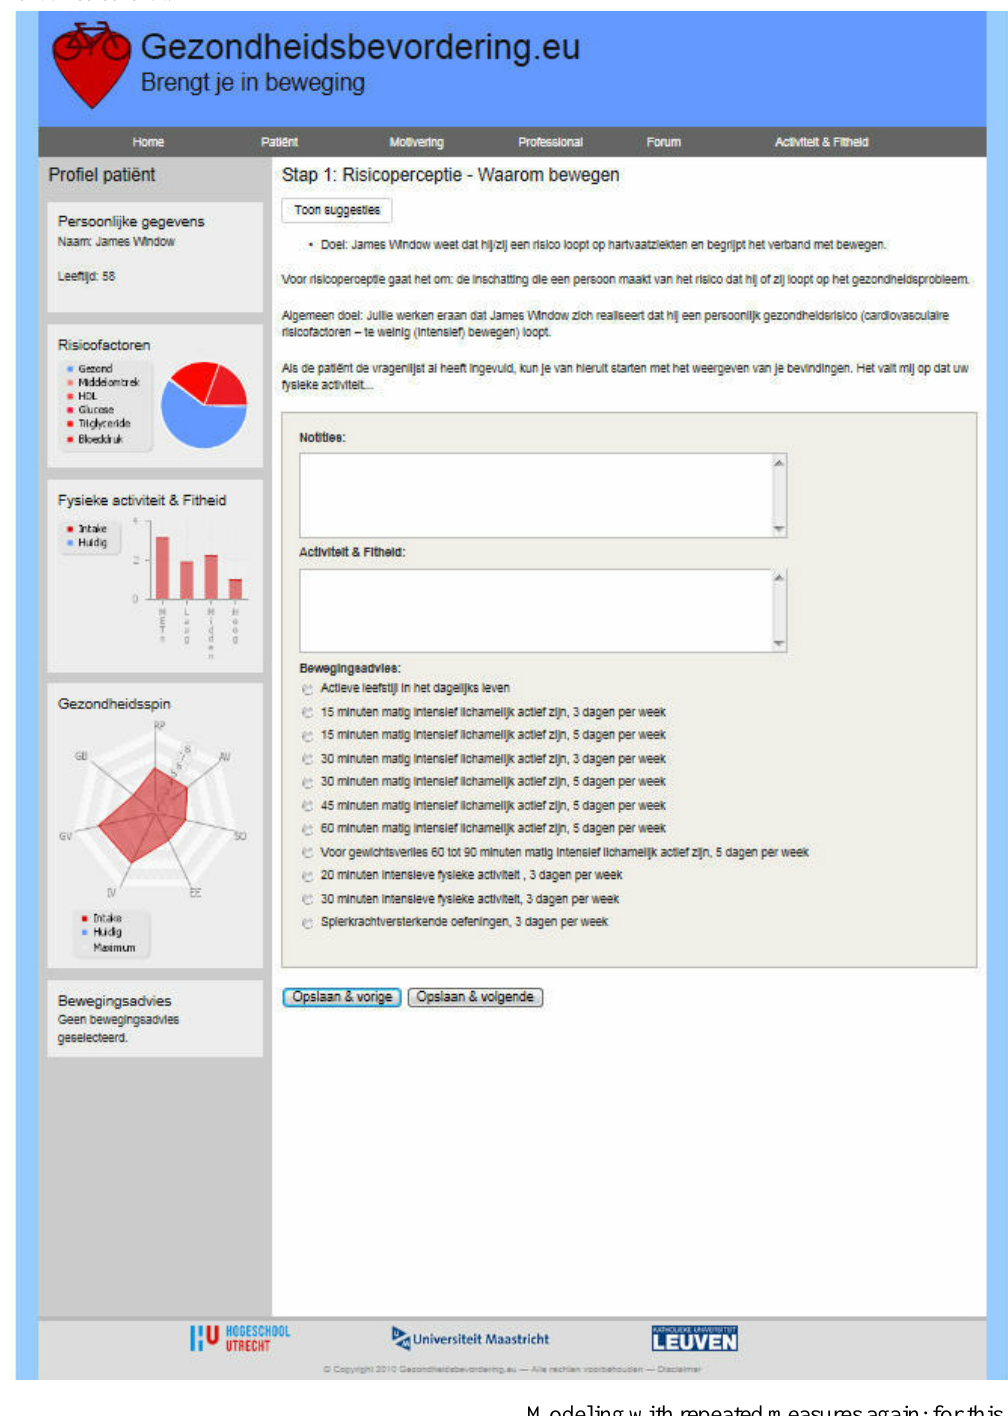
Figure 4. Intervention